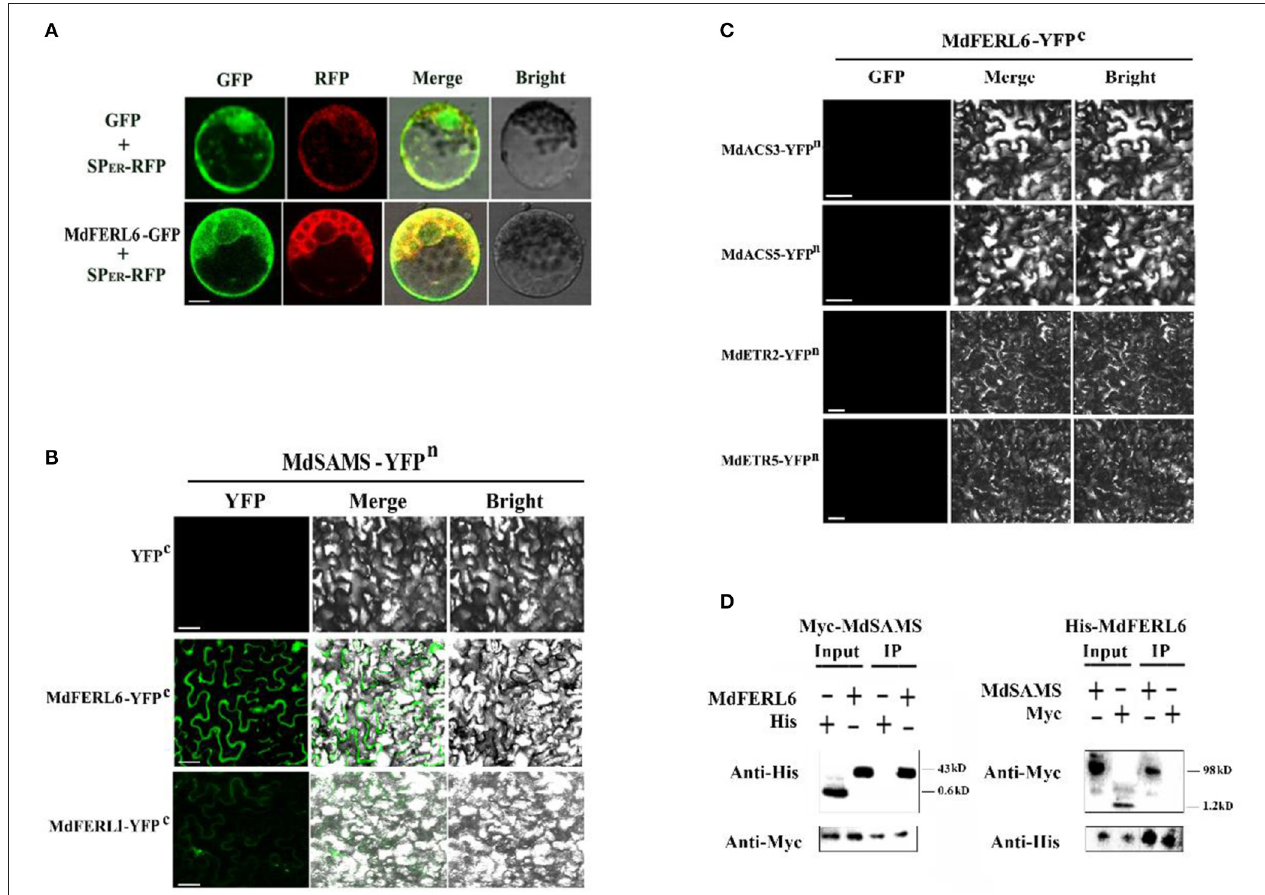
FIGURE 7 | Subcellular localization of MdFERL6 and its physical interaction with proteins involved in ethylene production and signal transduction. (A) Subcellular localization of MdFERL6. pMDC83- MdFERL6 was transformed into maize ( Zea mays ) protoplasts, and fluorescence was observed by confocal microscopy. Bars = 10 µ m. (B) Bimolecular fluorescence complementation (BiFC) analysis of the physical interaction between MdFERL1 or MdFERL6 and MdSAMS, fused with the C-, C-, and N-terminus, respectively, of yellow fluorescent protein (YFP; designated as YFPc or YFPn, respectively). Different combinations of the fused constructs were co-transformed into tobacco ( Nicotiana tabacum ) cells, and visualized using confocal microscopy. YFP and bright-field were excited at 488 nm and 543 nm, respectively. Bars = 20 µ m. (C) BiFC analysis of the physical interaction between MdFERL6 and MdACS3, MdACS5, MdETR2, and MdETR5. MdFERL6 was fused to the C-terminus of YFP, while the other proteins were fused to the N-terminus of YFP. (D) Co-immunoprecipitation (Co-IP) assay of the interaction between MdFERL6 and MdSAMS in apple calli. MdFERL6 was fused with GFP/His using the pMDC83 vector, and MdSAMS was fused with Myc using the pCambia1300 vector.